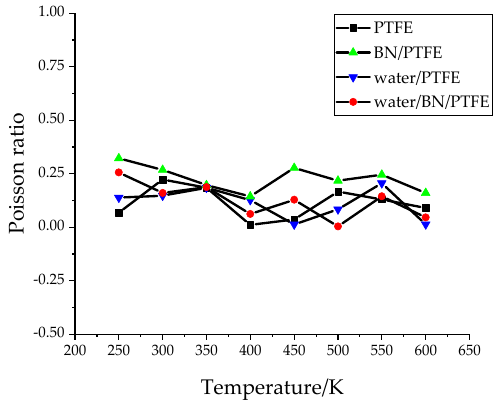
Figure 6. Bulk modulus versus temperature.